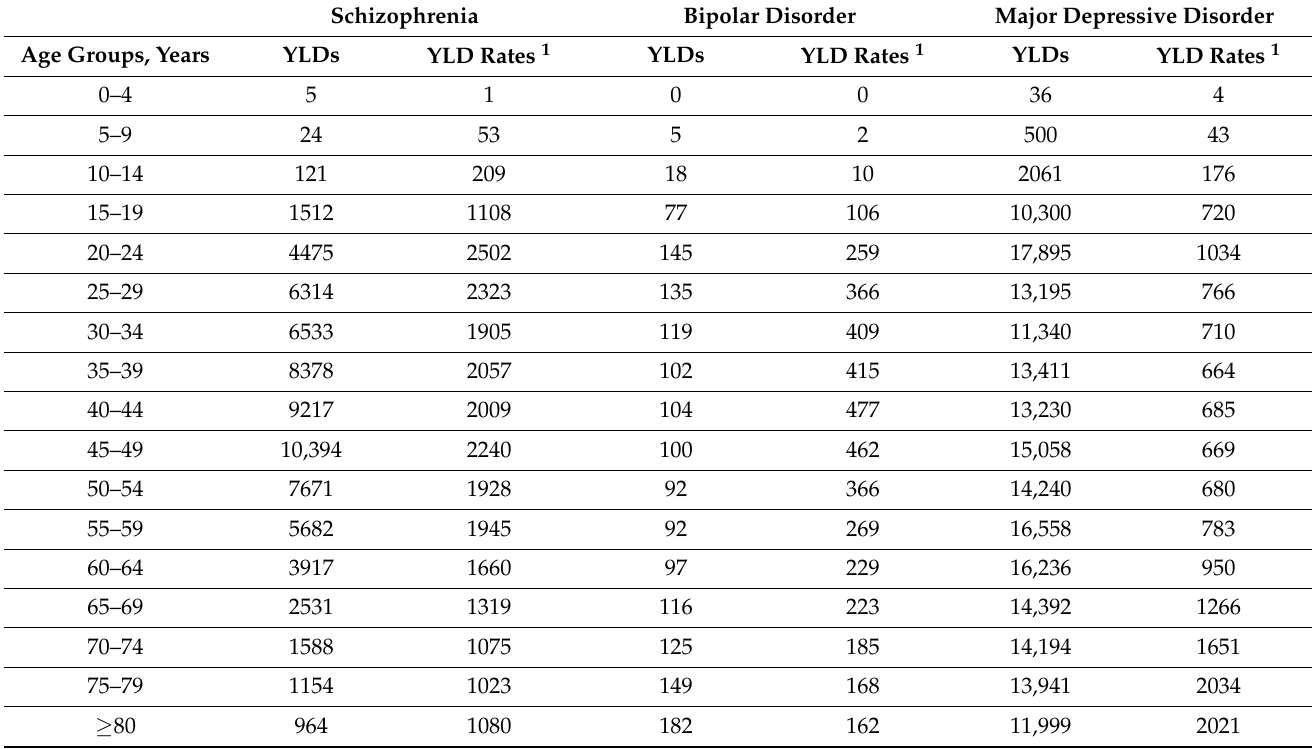
Table 5. Prevalence-based approach YLDs and YLD rates for major psychiatric disease among males by